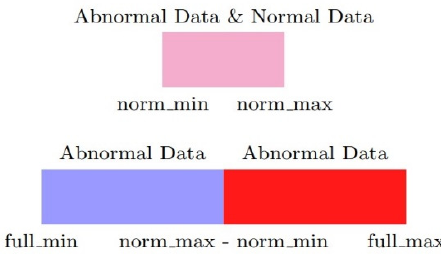
Figure 2. Split dimensions by parameter.